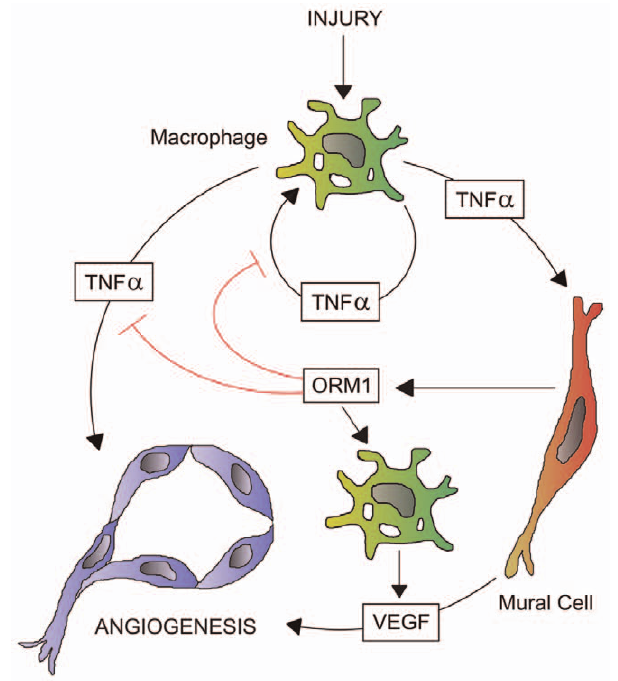
Figure 8. Schematic drawing showing regulation of injury- induced angiogenesis by ORM1. Macrophages produce TNF a in response to injury. TNF a stimulates angiogenesis directly by activating endothelial cells and indirectly by inducing production of VEGF by mural cells. TNF a also induces production of ORM1 by mural cells. ORM1 in turn suppresses TNF a signaling in macrophages and endothelial cells but has no inhibitory effect on mural cell signaling. ORM1 induces VEGF production by macrophages and promotes VEGF- mediated angiogenesis over time. Thus ORM1 fine tunes the angiogenic response by dampening TNF a stimulatory signals and by promoting VEGF-mediated downstream pro-angiogenic effects.